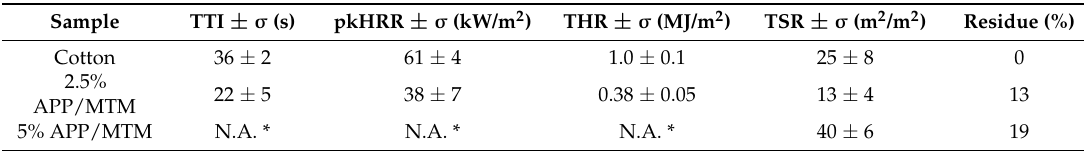
Figure 5. Average Heat release rate (HRR) plots of untreated and treated cotton during cone calorimetry tests and schematic representation of sample behavior under testing. Table 4. Cone calorimetry data of untreated and treated samples.